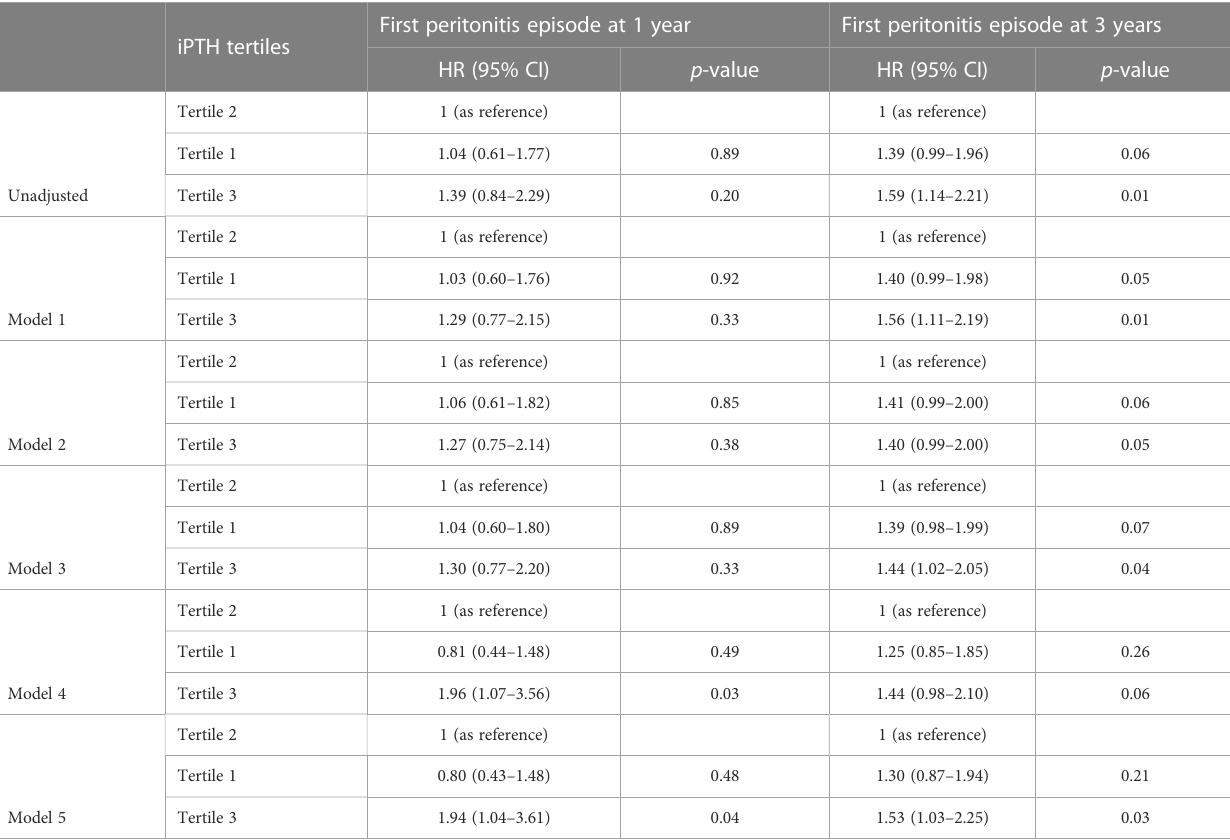
TABLE 2 Cox regression models of the fi rst peritonitis episode for serum intact parathyroid hormone (iPTH) level (tertiles as